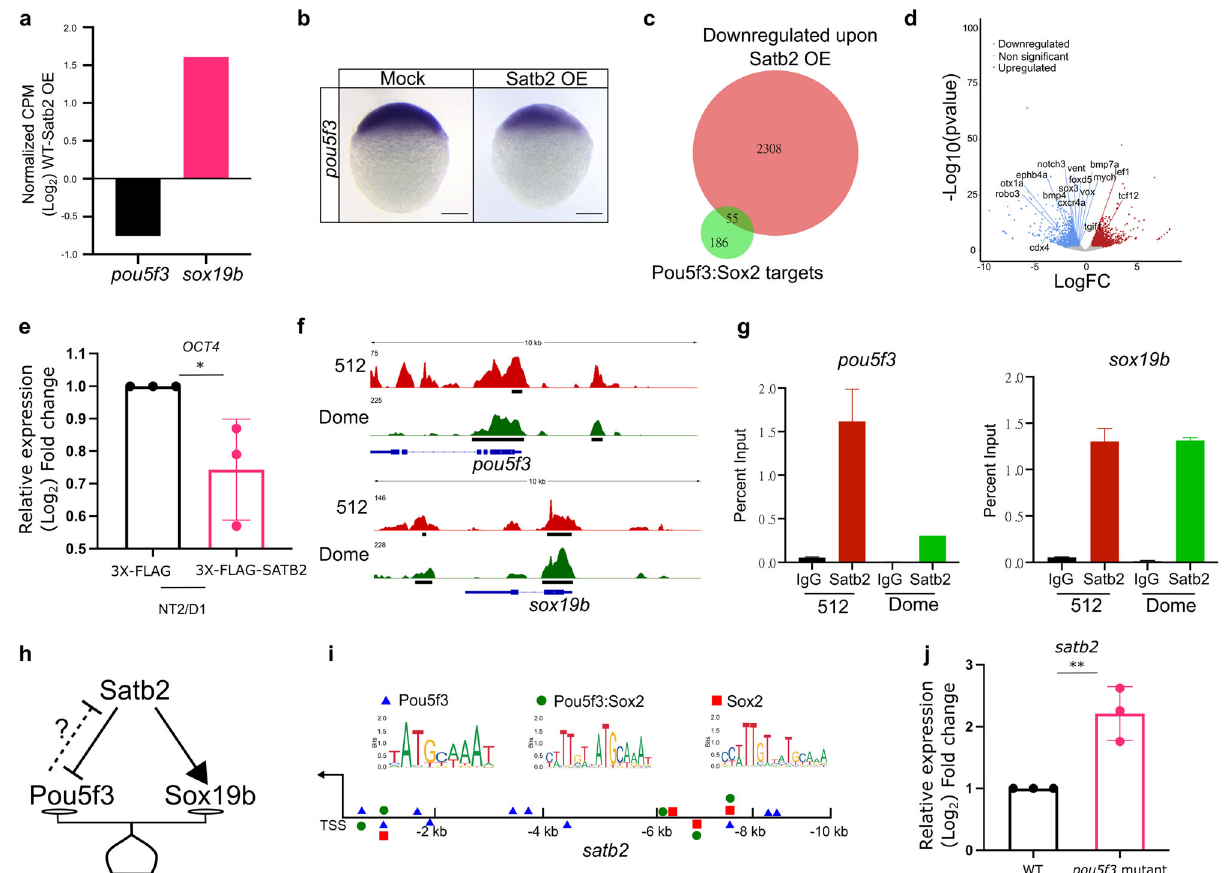
Fig. 6 Maternal Satb2 functions during ZGA by regulating pioneer factors. a Relative gene expression for pou5f3 and sox19b as determined by RNA-seq analysis (FDR < 0.05). b Lateral view of zebra fi sh embryo at 4 hpf for WISH using RNA probe against pou5f3 in control and Satb2 overexpressing embryos, n = 24, N = 3 biologically independent experiments Scale bar = 100 µ m. c Venn diagram analysis showing the overlap between negative targets of Satb2 and known genomic targets of Pou5f3 and Sox2. d Volcano plot of differentially expressed genes upon overexpression of Satb2 analyzed at 4.5 hpf. DE genes with FDR < 0.1 and log2 fold change > ±0.58 are colored as red for upregulated, blue for downregulated, and gray for unchanged or non-signi fi cant genes. Key Pou5f3: Sox2 target genes are labeled. e Quantitative RT-PCR analysis of OCT4 (human homologue of pou5f3 ) expression in NT2/D1 cells upon overexpression of SATB2 as compared to FLAG overexpression. * Signi fi es P -value 0.049 as calculated by the unpaired Student ’ s two-tailed t -test, N = 3 biologically independent experiments. Error bar represents ±SEM. f IGV snapshot of Satb2 ChIP-seq at 512 cells (red) and Dome stages (green) on genomic loci of pou5f3 and sox19b . g Quantitative relative enrichment (ChIP-qPCR) represented as percent input using isotype-matched IgG and anti-Satb2 antibody for genomic locus (TSS) of pou5f3 and sox19b . ** indicates P -value < 0.001 as calculated by the Student ’ s two-tailed t -test, N = 2. h The predictive regulatory model between maternal Satb2 and pioneer factors during the establishment of ZGA. i Schematic for satb2 promoter displaying motif sites marked for Pouf53, Pou5f3: Sox2 and Sox2. j qPCR analysis for satb2 expression at 4.5 hpf in pou5f3 mutant embryos. ** Signi fi es P -value < 0.0082